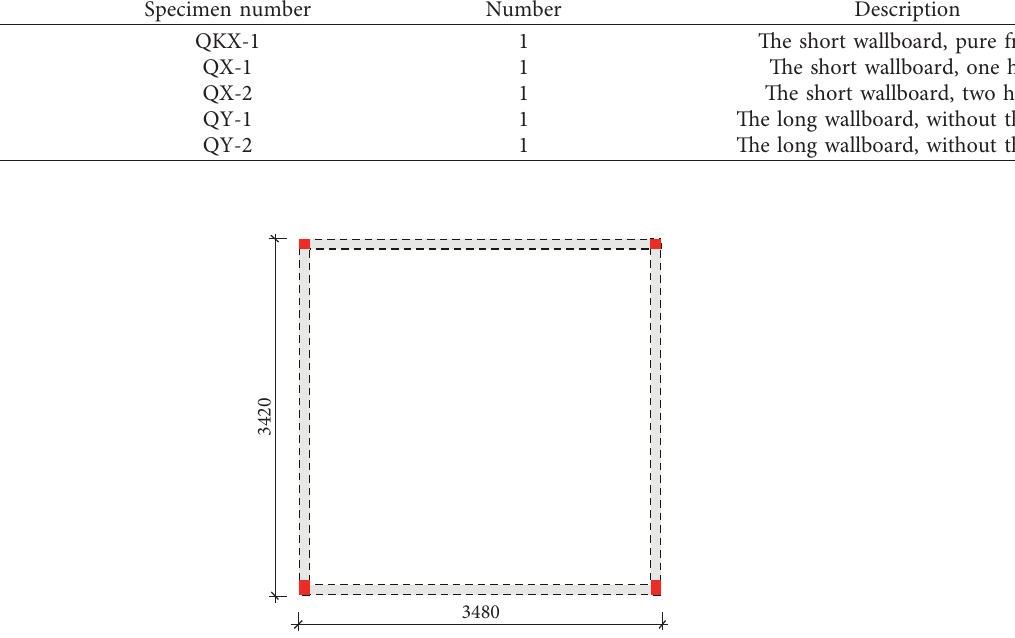
Figure 3: Model of